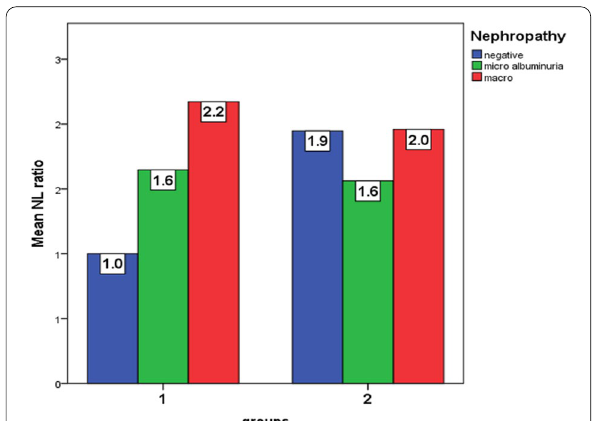
Fig. 1 The difference in the mean value of NLR in geriatric patients screened for retinopathy in Group 1 (T2DM with HTN) and Group 2 (only T2DM)